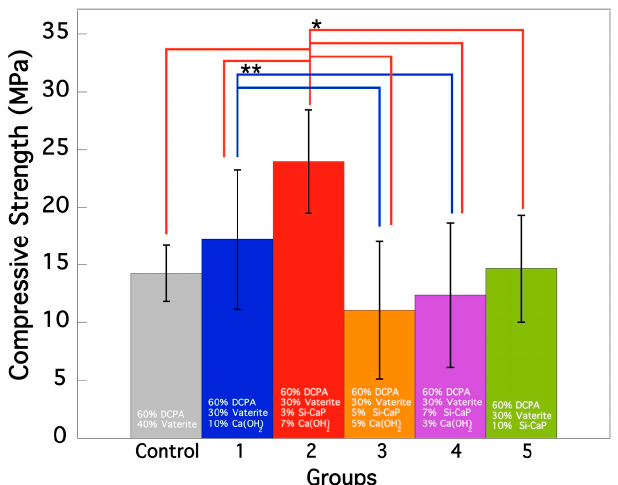
Figure 1. Compressive strength evaluation of CO 3 Ap- Si-CaP -Ca(OH) 2 cement specimens after 72 h of treatment. Ten specimens of each group were measured for compressive strength, and error bars indicate the standard deviation. Symbols of * and ** were showed statistically significant between the